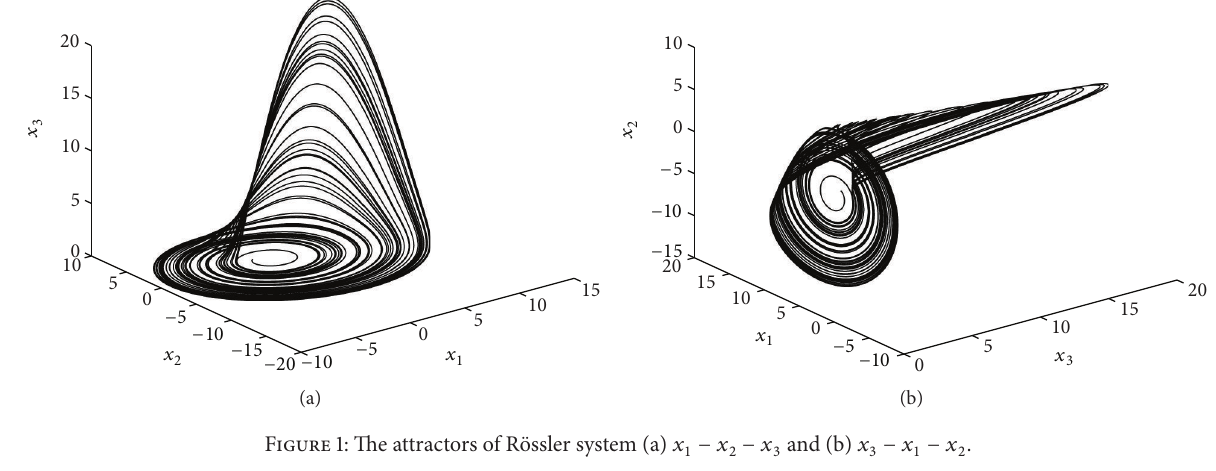
Figure 1: The attractors of R¨ossler system (a) 𝑥 1 − 𝑥 2 − 𝑥 3 and (b) 𝑥 3 − 𝑥 1 − 𝑥 2 .